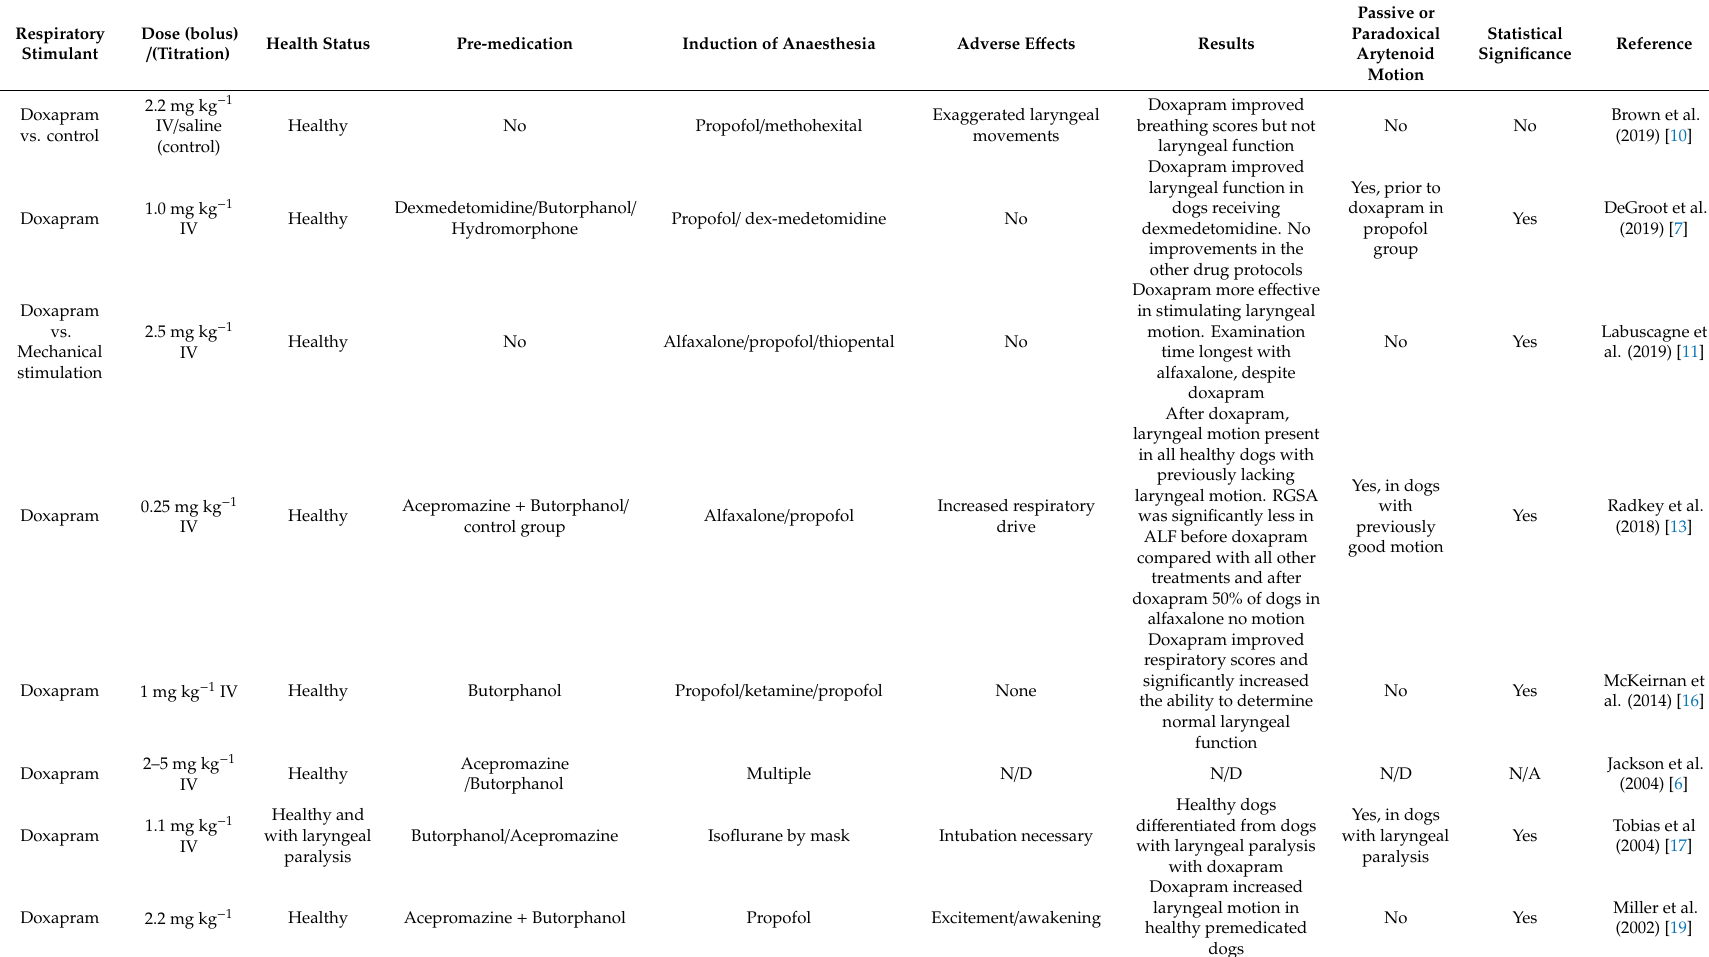
Table 4. The e ff ects of doxapram on the laryngeal motion in healthy dogs and dogs with laryngeal